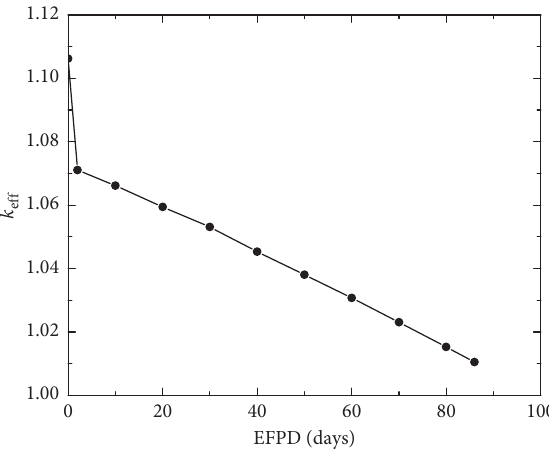
Figure 5: Burnup reactivity of the MPRR core.